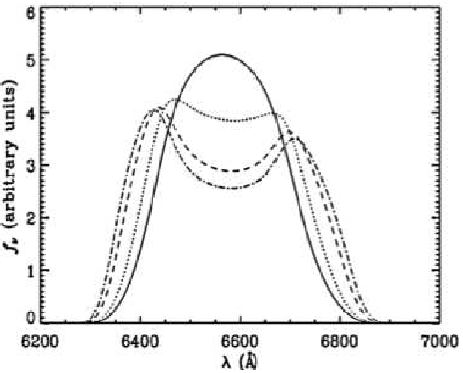
Fig. 1. The profile of the H (cid:11) emission line with increasing optical depth through the disk-wind. The increase in optical depth from one profile to another is one order of